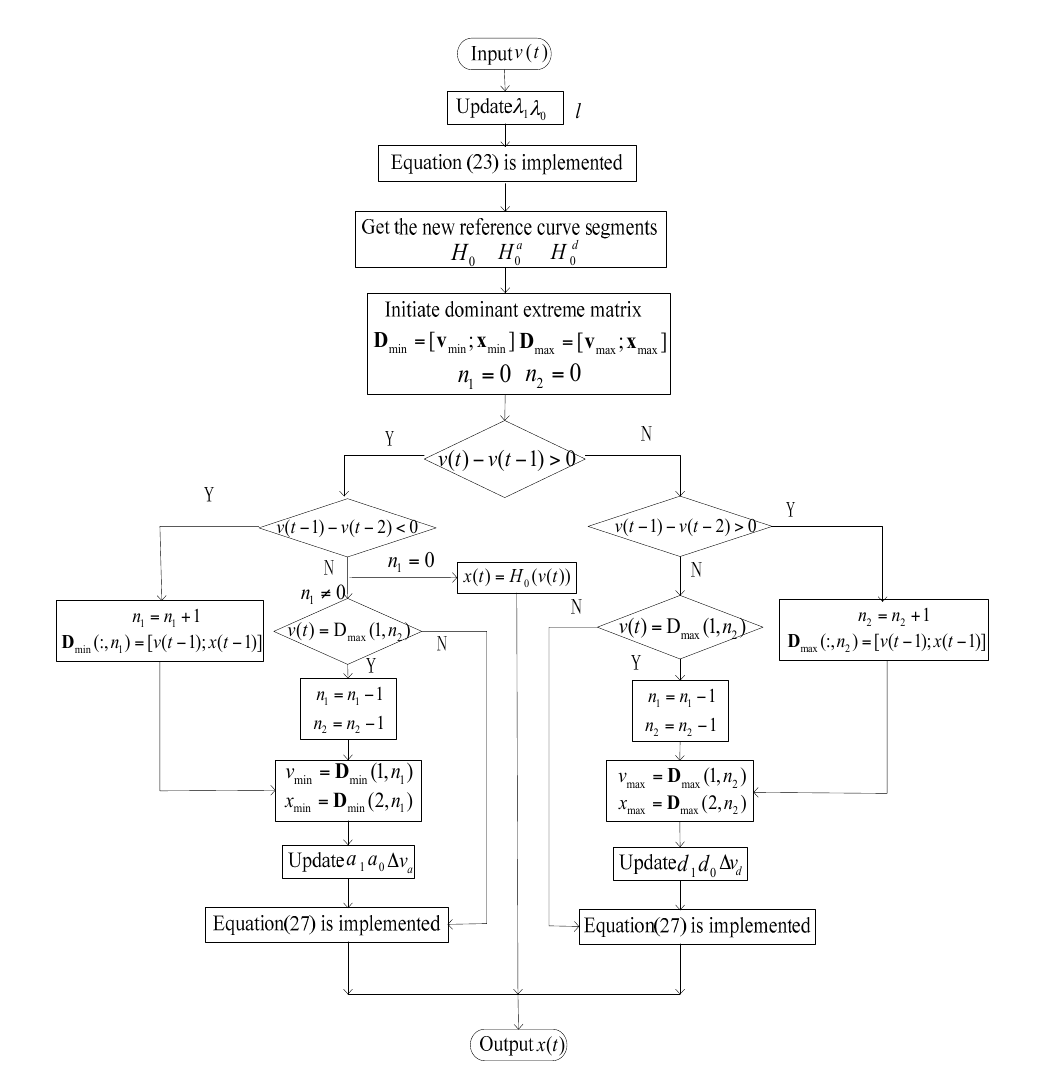
Figure 16. The schematic diagram of the modeling.